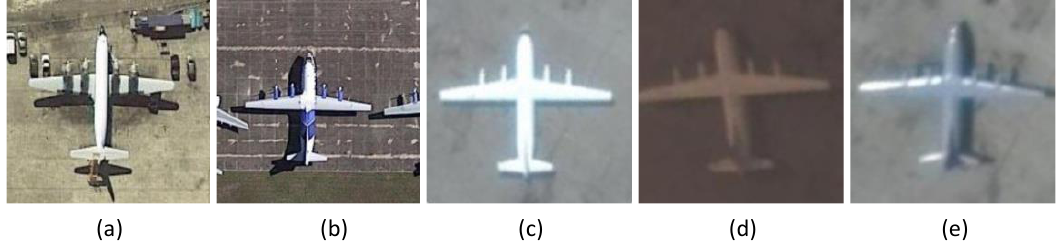
Figure 12. Examples of Type1 in the training set, where ( a ) is obviously different from other images in that the rear side of the wing has a certain curvature, while the rear side of the wing of other images is a straight line. (a)